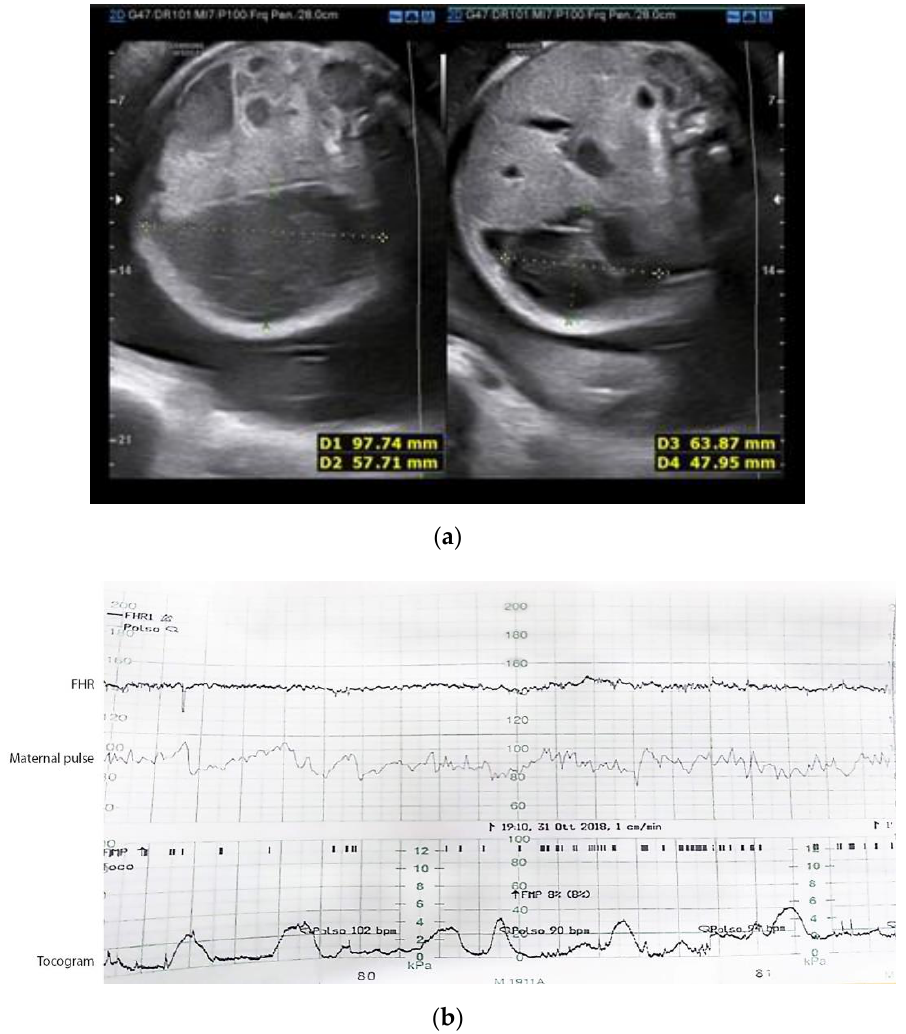
Figure 3. ( a ) Additionally, in this second case, we can observe the typical abdominal cyst, associ- ated with peritoneal calcifications and polyhydramnios, typical characteristics of ileum meconium.; ( b ) Three tracings are shown in this image: the first shows the fetal heart rate ‘FHR’, the second the maternal heart rate and the third the tocogram or uterine contractile activity. In this case, the fetal heart rate shows little variability due to the non-reassuring fetal status. ACOG (American College of Obstetricians and Gynecologists) Classification is Class